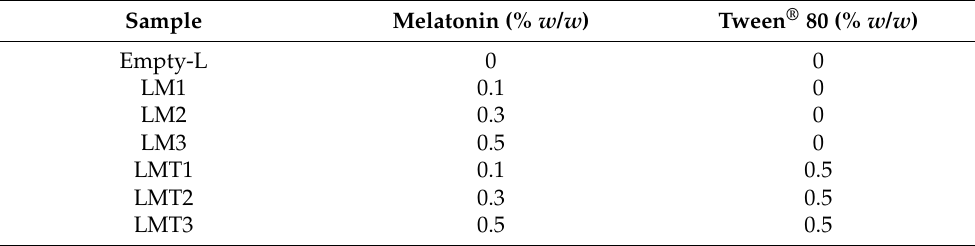
Table 1. Composition of PLA-based nanofiber samples.